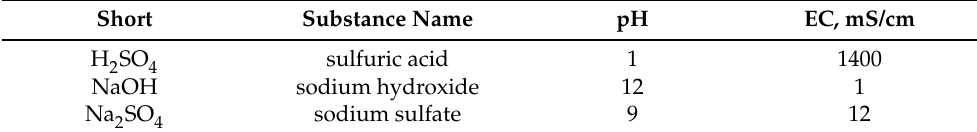
Table 1. Substances used in simulations.